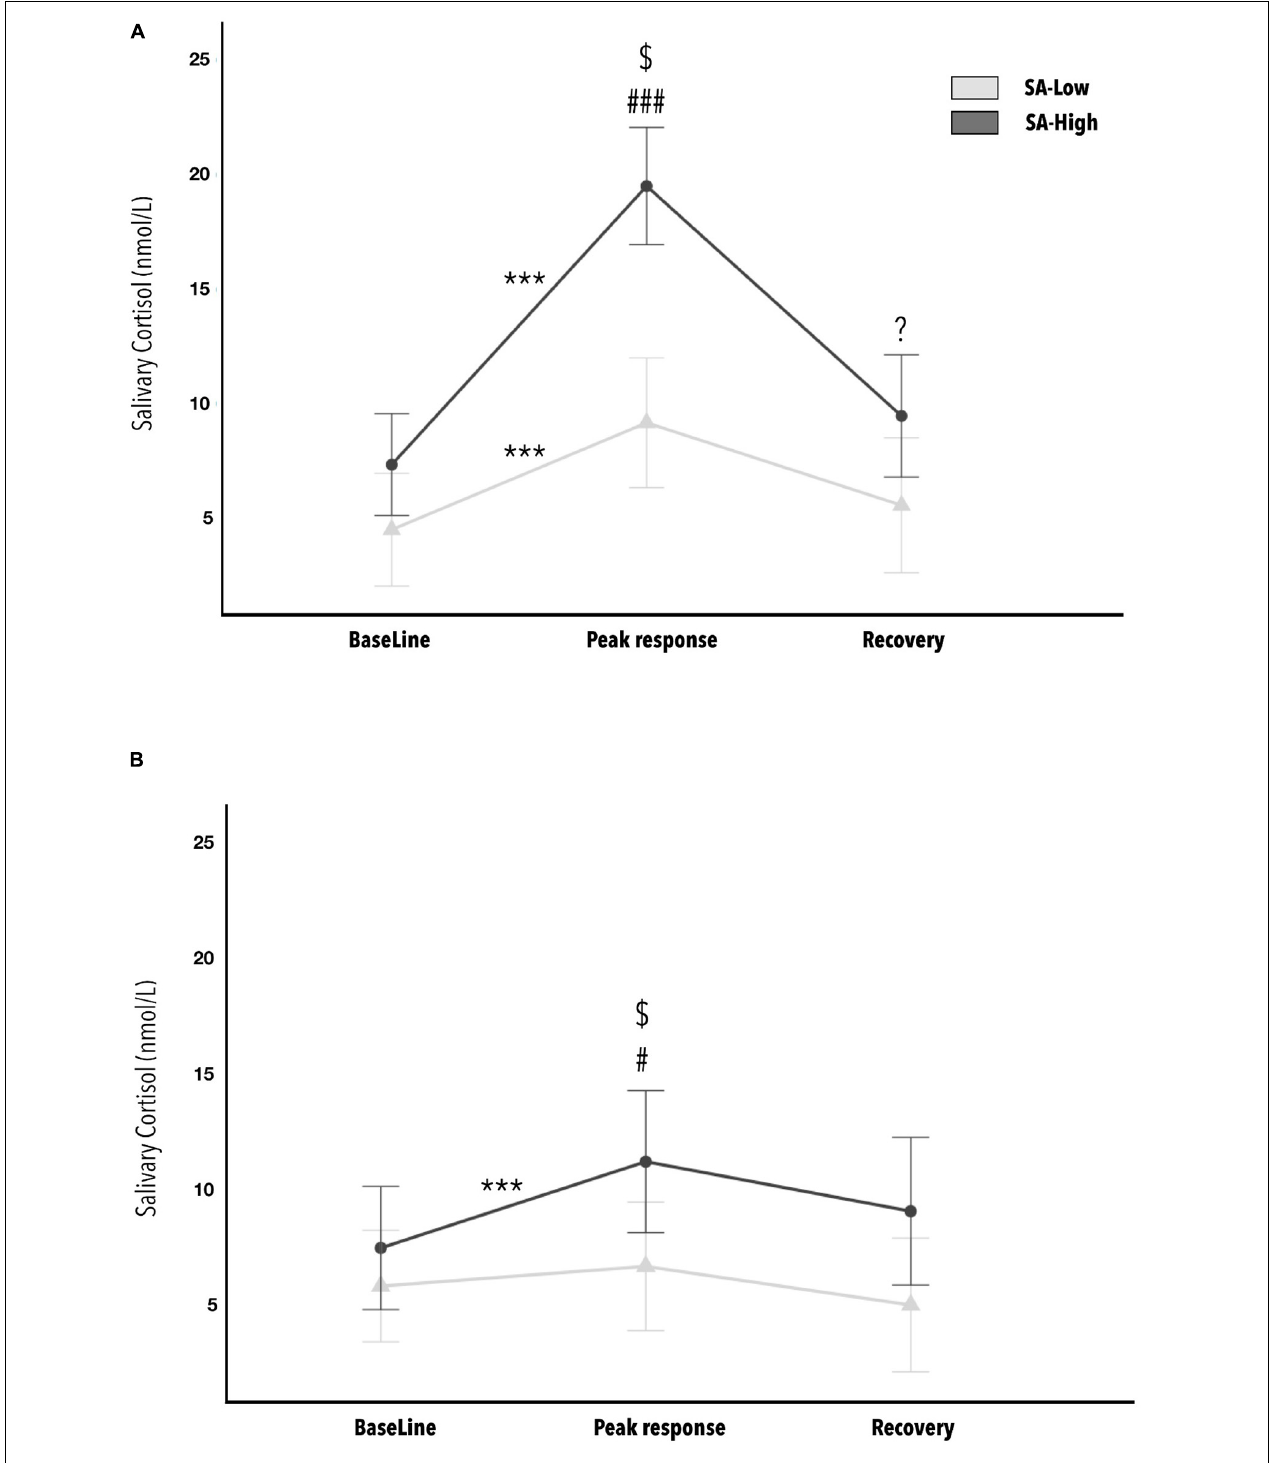
FIGURE 5 | Average concentrations of cortisol in saliva: before (baseline), after (cortisol response) and 20 min following (recovery) the end of the stress-inducing experimental paradigm, as a function of state-anxiety and cognitive reserve levels (Low versus High). Figure (A) is the CR-Low group, while Figure (B) is for the CR-High group. Statistically significant post hoc analyses are marked with (*) for comparisons between phases (baseline, cortisol response and recovery). The symbol (#) indicates statistically significant post hoc between SA-Low versus SA-High groups. The ($) symbol indicates statistically significant post hoc with p < 0.001 within the SA-High group, between the groups CR-Low (A) and CR-High (B) . The p-values showing one, two, or three * or # represent values < 0.05, < 0.01, and < 0.001, respectively. The error bars show standard error. (*) This symbol refers to within-group comparisons. While this ( # ) symbol refers to between-group